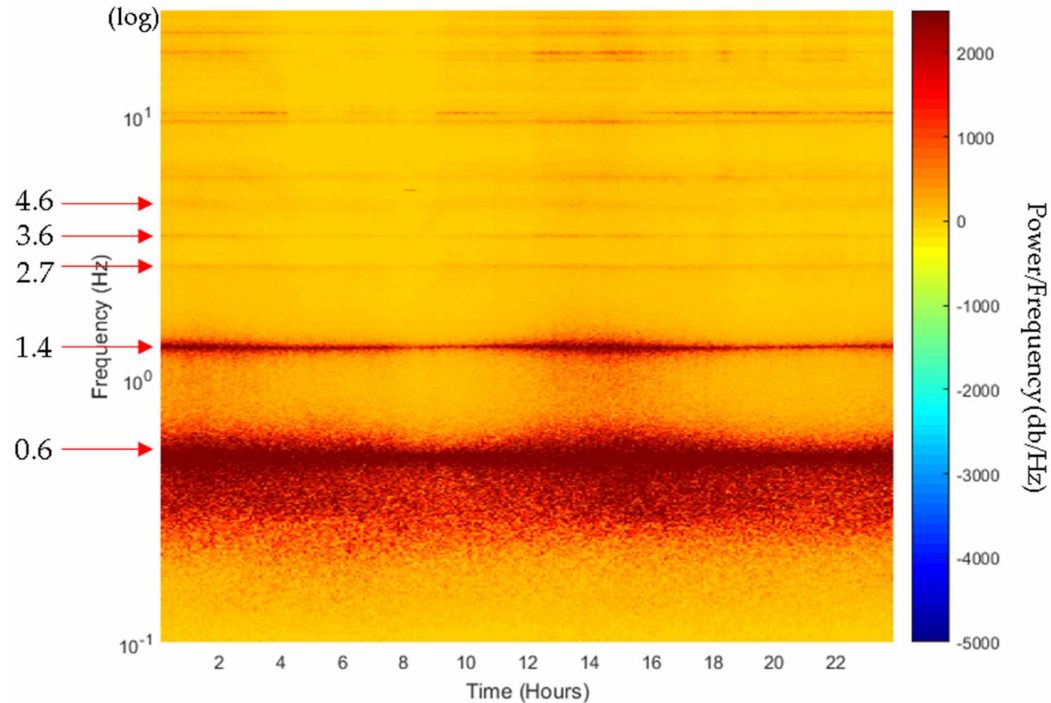
Figure 7. Vibration frequencies of met mast structure on 30 May 2016 (0 − 25